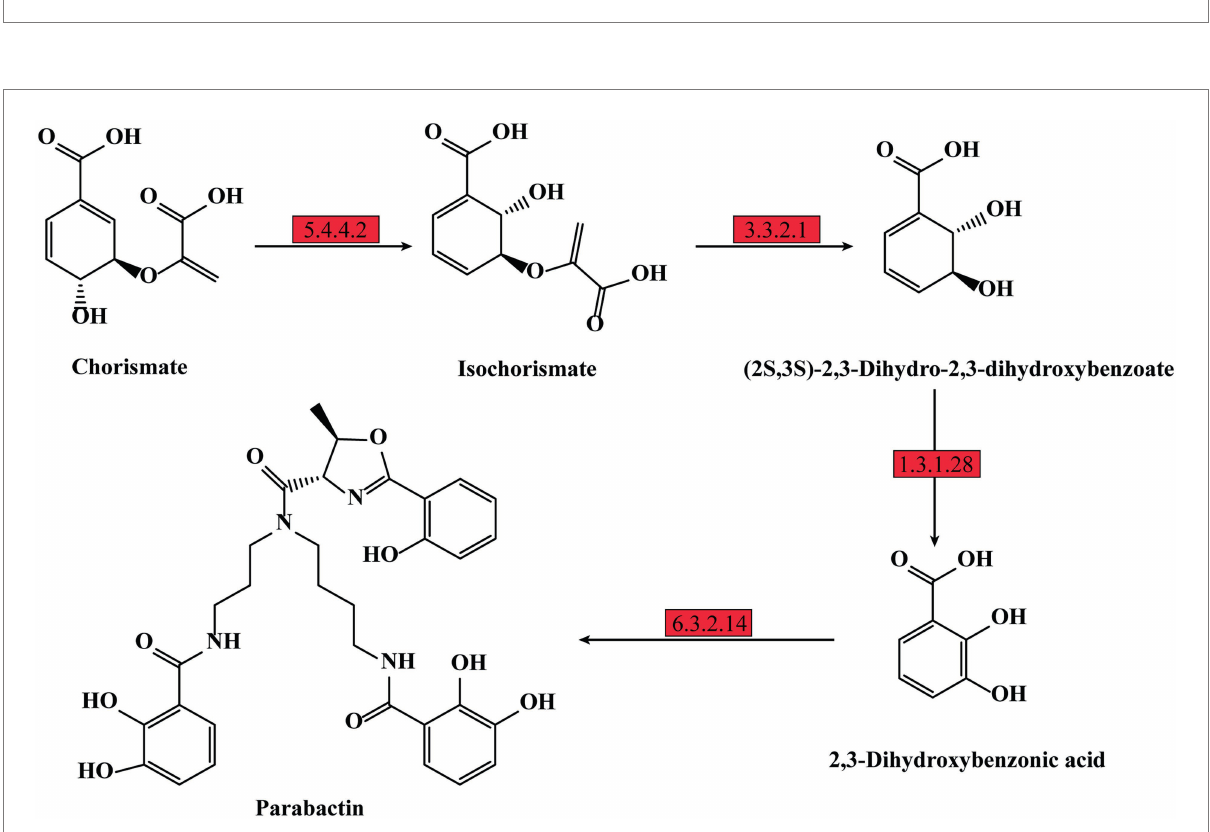
FIGURE 8 Schematic metabolic pathway of parabactin biosynthesis in P. denitrificans per the KEGG pathway database (https://www.genome.jp/kegg/ pathway.html). The up-regulated expressed genes of the enzymes are marked with red, and the detailed different expression values could be found in Supplementary Table